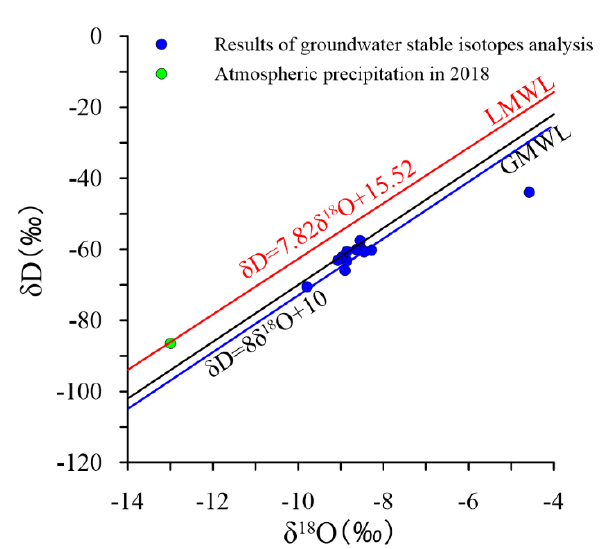
Figure 15. Diagram of the global meteoric water line (GMWL) and local meteoric water line.